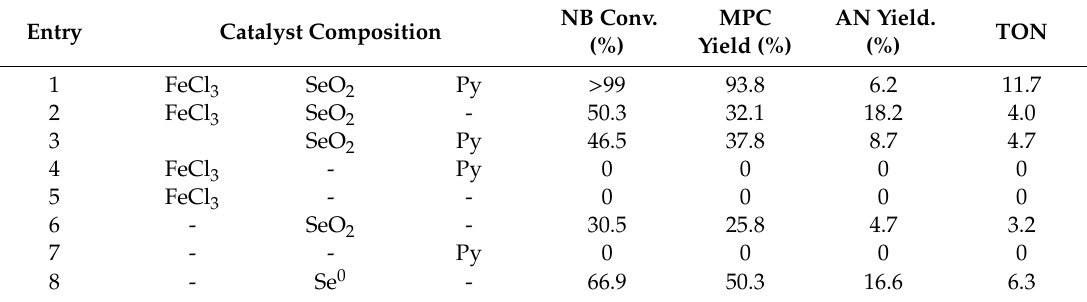
Table 1. Screening of the catalysts system a .